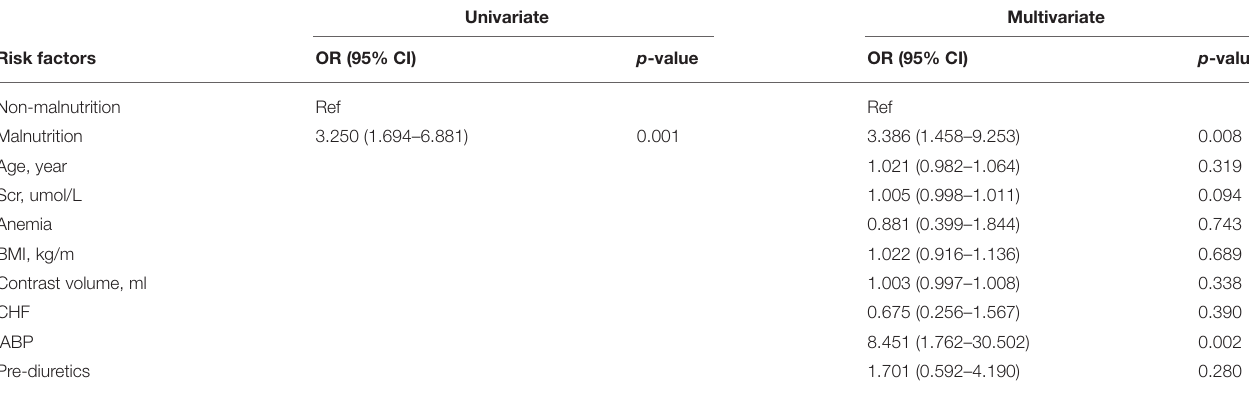
TABLE 3 | Risk of CA-AKI-associated nutritional state in patients undergoing PCI with age ≤ 75 years (N = 1791) (Cut-off value based on traditional threshold). Univariate